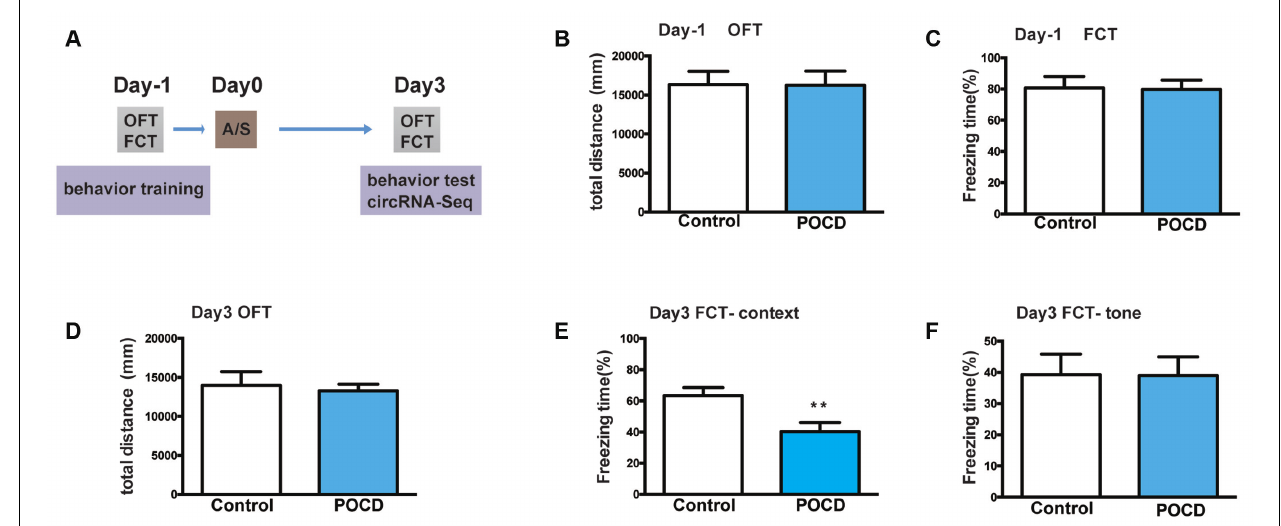
FIGURE 1 | Hippocampus-dependent learning and memory, but not hippocampus-independent learning and memory or motor activity was impaired by anesthesia/surgery in aged mice. (A) The experimental process’ schematic diagram. (B) The baseline of total distance the elderly mice traveled in open field test (OFT) during the training period 1 day before surgery. (C) The baseline of freezing time (%) in fear conditioning test (FCT) of aged mice during the training duration 1 day before surgery. (D) The total distance traveled in OFT 3 days after the operation. (E) Freezing time percentage in the FCT context test 3 days after surgery. (F) Freezing time percentage in the FCT tone test 3 days postoperatively. Data for each group are shown as the mean ± standard error ( n = 10). ** p < 0.01 compared with the control group.